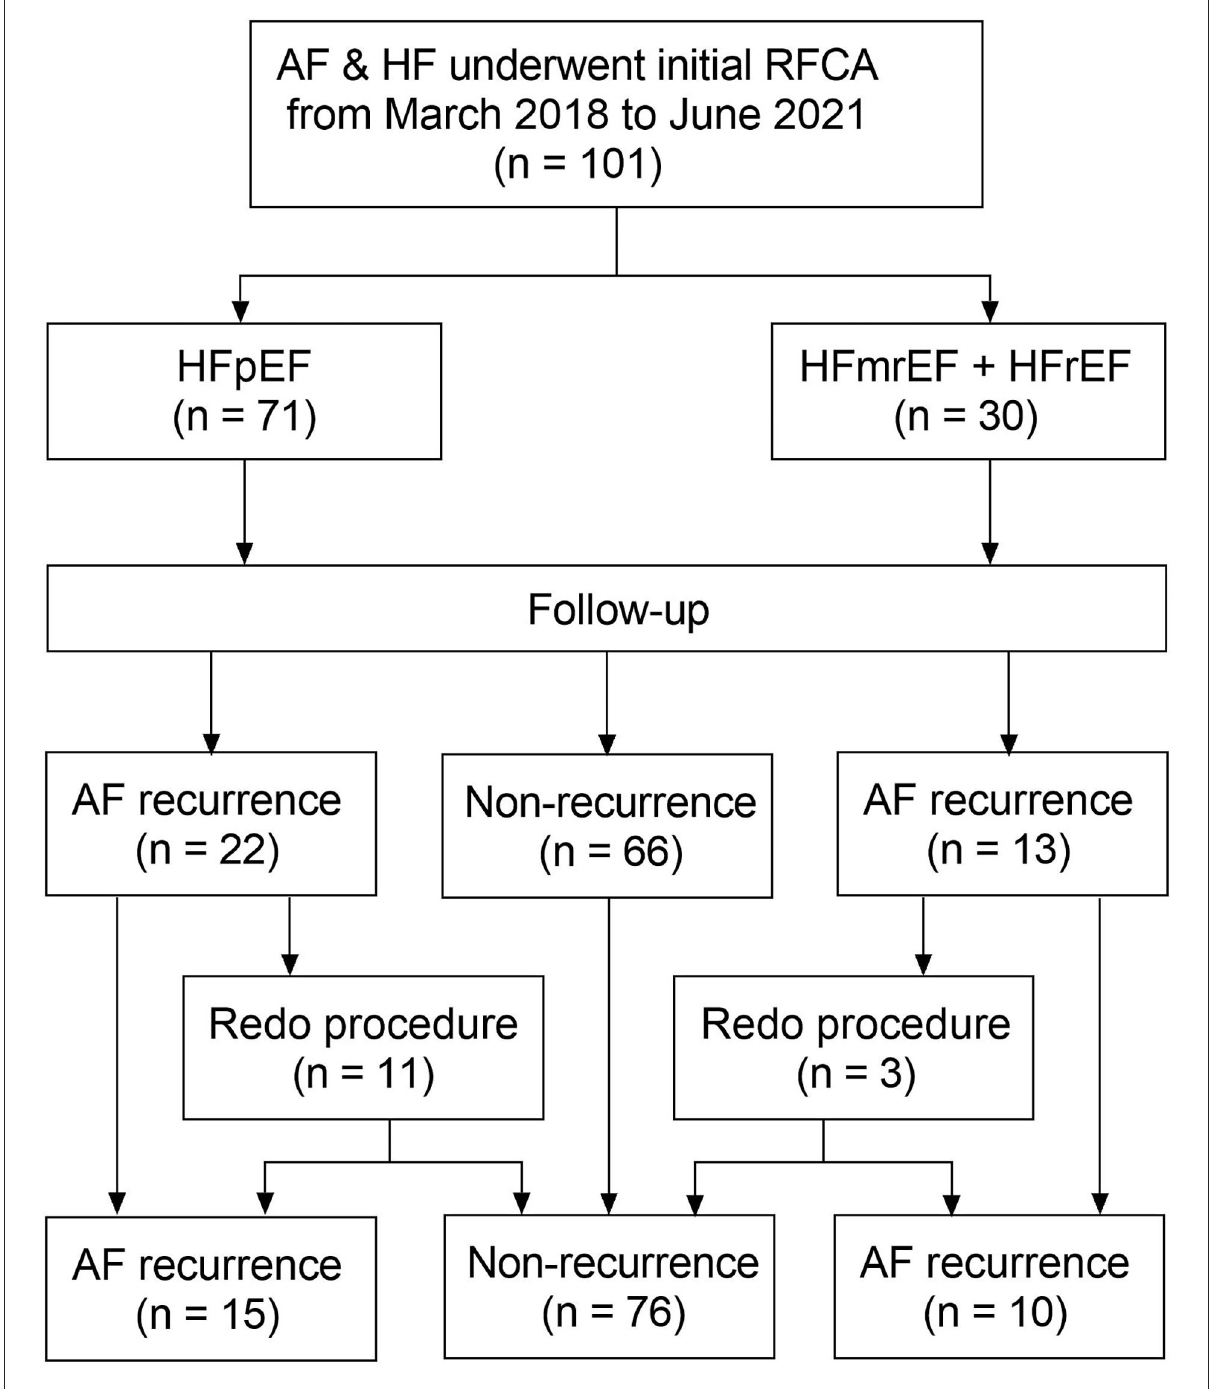
FIGURE1 Flow diagram of the study. AF, atrial fibrillation; HF, heart failure; RFCA, radiofrequency catheter ablation; HFpEF, heart failure with preserved ejection fraction; HFmrEF, heart failure with mid-range ejection fraction + heart failure; HFrEF, heart failure with reduced ejection